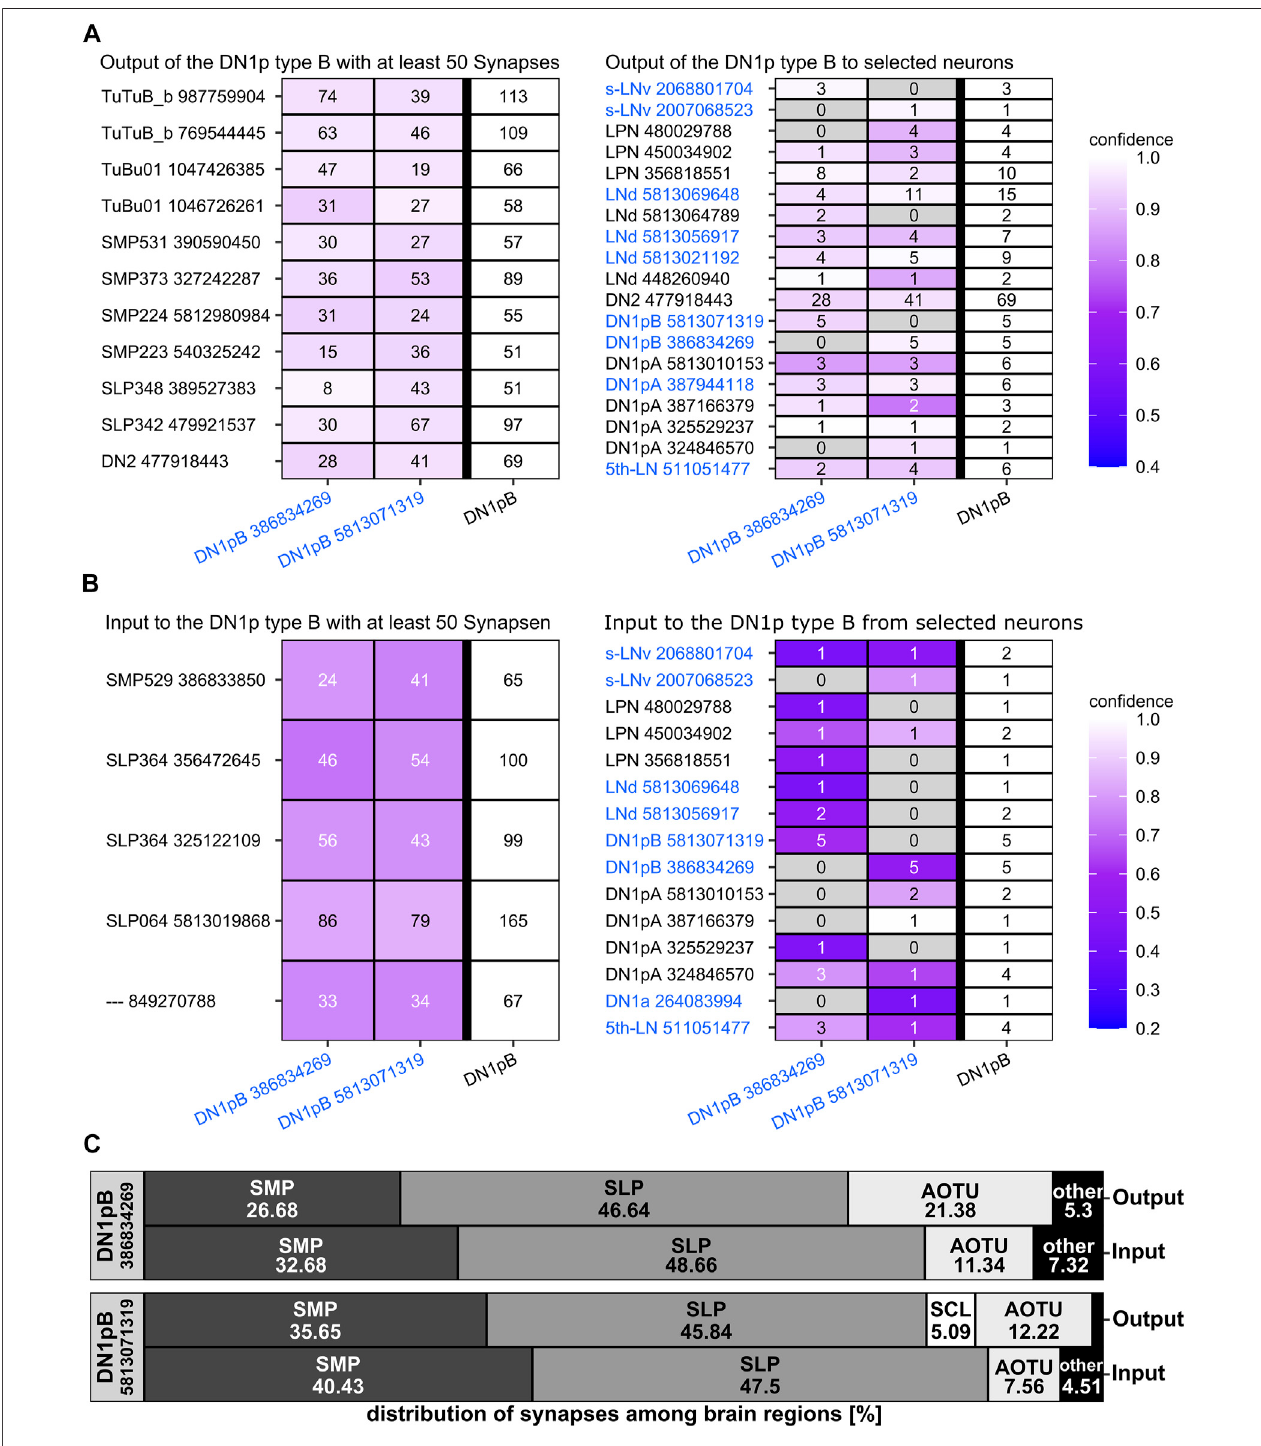
FIGURE 9 | Synaptic partners of the two annotated CRY-positive type B DN 1p s from the hemibrain. (A) Postsynaptic partners of the CRY-positive type B DN 1p s with at least 50 synapses and postsynaptic clock neurons. As expected, the DN 1p s project on many tubercle bulb neurons (TuBu) of the anterior optic tubercle (AOTU) and to tubercle-tubercle neurons (TuTuB) which are connecting the AOTUs of both hemispheres. Additionally, neurons with their cell bodies in the superior lateral protocerebrum (SLP) as well as in the superior medial protocerebrum (SMP) get strong input by the CRY-positive type B DN 1p s. Further, they give strong input to oneDN 2 astheonlyclockneuronwhichisgettingstronginputfromthetypeBCRY-positiveDN 1p s.OtherclockneuronsliketheLPNandthetypeADN 1p sgetonlyweak inputfromtheCRY-positiveDN 1p s. (B) AstheCRY-positiveDN 1p sgiveoutputtoneuronsoftheSMPandSLPtheyalsodogetstronginputbyneuronsfromthesebrain